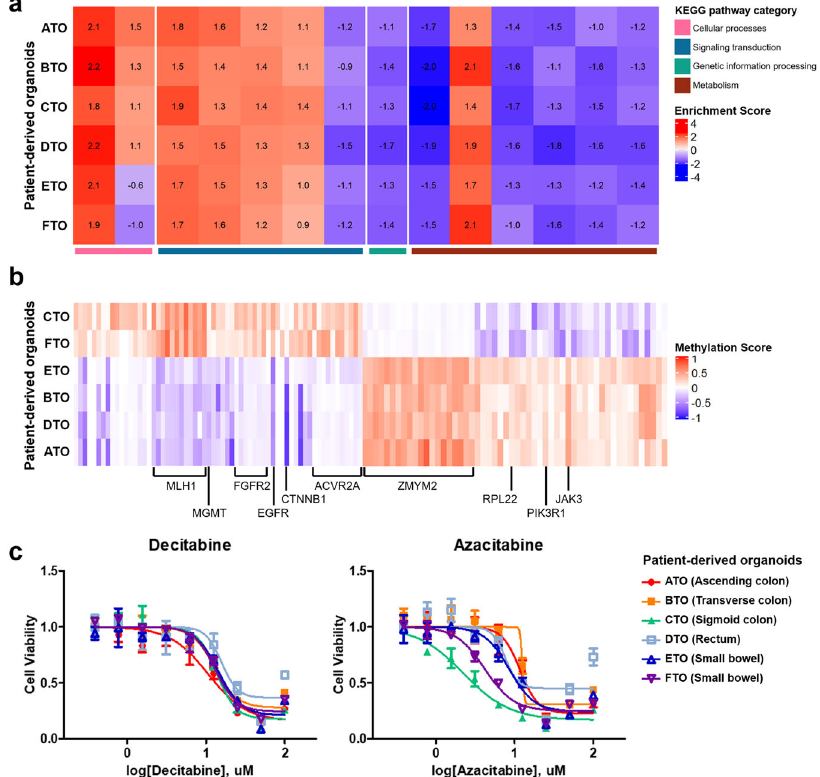
Fig. 4 Heterogeneous epigenetic changes affect DNA repair system, leading to heterogeneous tumor development patterns. See also Supplementary Fig. 5. See also Supplementary Data 4 . a GSEA analysis using normalized promoter methylation score of PDOs. The KEGG signaling pathway pathways are categorized and indicated with representative colors. Tumor-related pathways ( n = 14) were signi fi cantly dysregulated compared to the normal mucosa. b Differentially methylated genes separating C and F-TO from the rest (standard deviation < 0.1). Hypermethylated promoter regions ( n = 63) and hypomethylated promoter sites ( n = 54) were identi fi ed (red, hypermethylated; blue, hypomethylated). c The sigmoid curves of PDOs treated with two different types of methyltransferase inhibitors. Each PDO is marked with representative colors. The error bars represent the standard deviations ( n =